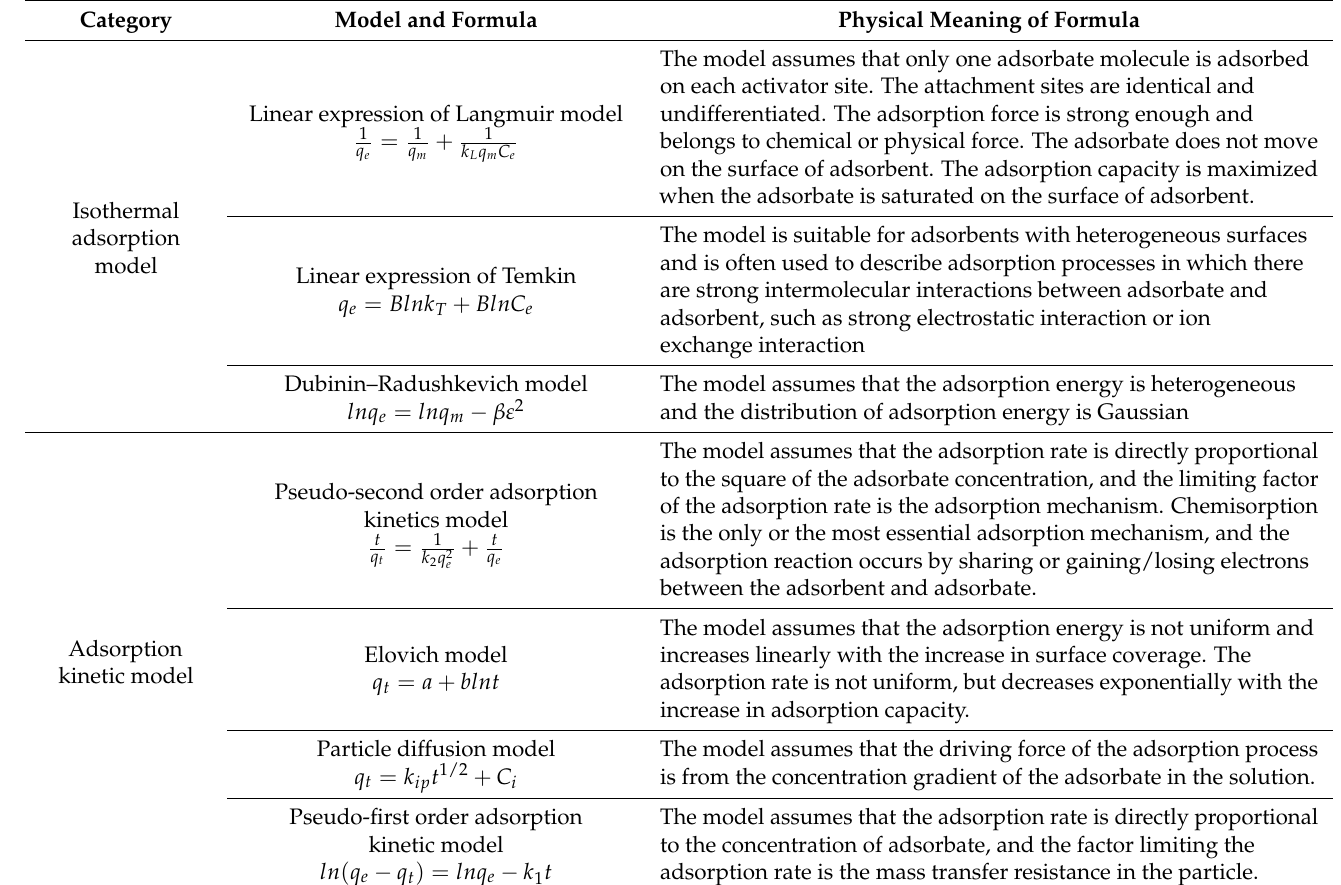
Table 1. Adsorption model formula and its physical